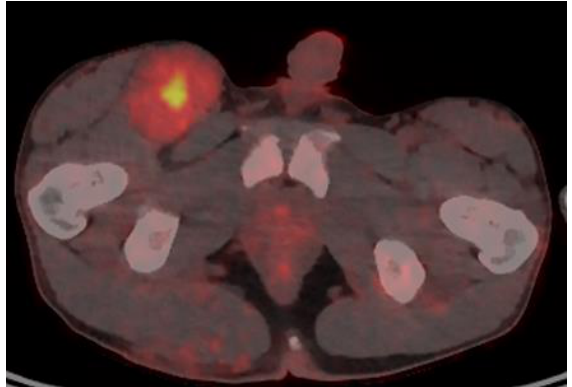
Figure 2. 18F-FDG PET/CT of a patient with NF1 and an MPNST of the right groin, with a maximal SUV of 7.